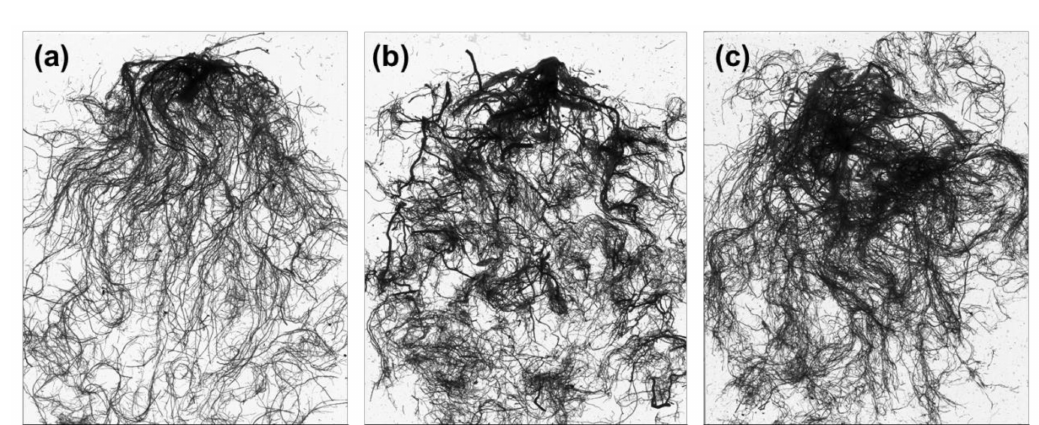
Figure 5. Root scan imagines of plants grown in ( a ) 100% coco coir fibre (CC), ( b ) peat-mix media (PM) and ( c ) peat-mix + 30% green fibre media (G30) of genotype 0.2x. Genotype-specific di ff erences were found for the DW yield of roots per plant. Plants of genotype − 1 0.2x reached 1.52 g DW plant , a higher value than genotype KAN (0.55 g plant